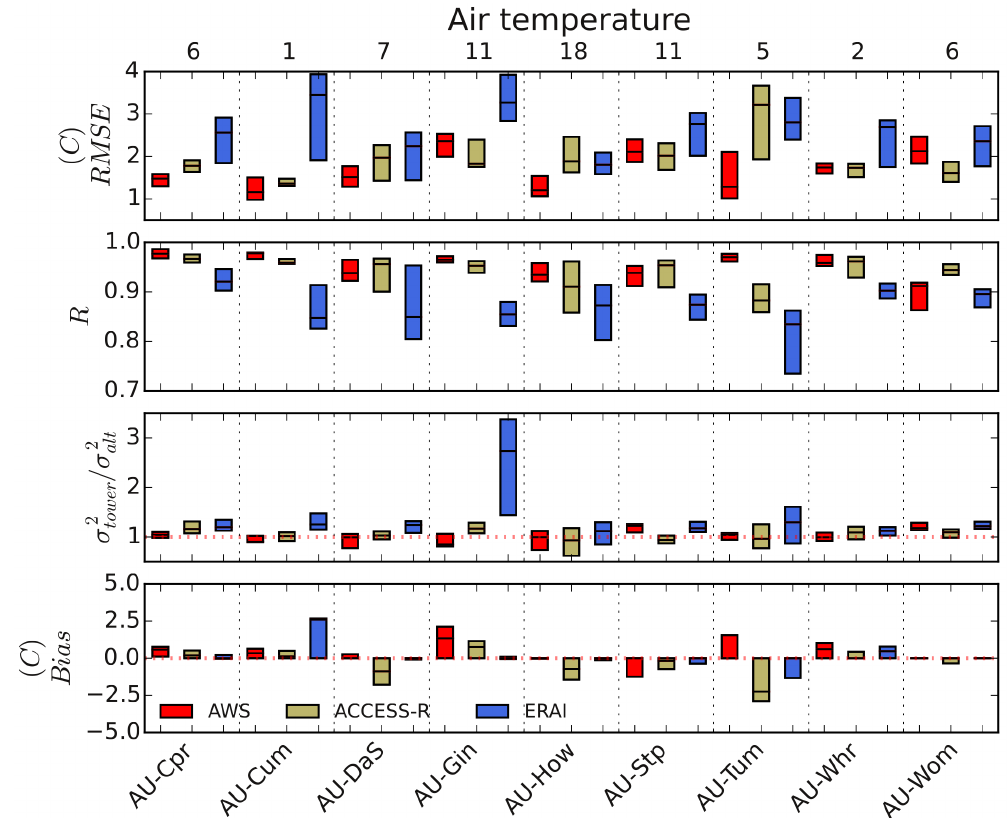
Figure 5. Box plot of bias, variance ratio, correlation coefficient and root mean square error for the comparison of tower and alternate air temperature at nine OzFlux sites. Statistics for AWS are plotted in red, ACCESS-R in khaki and ERA-Interim in blue. Box lengths represent the 75 and 25% quartiles and the median is plotted as a solid line across the boxes. Numbers at the top are the percentage of missing data that are gap